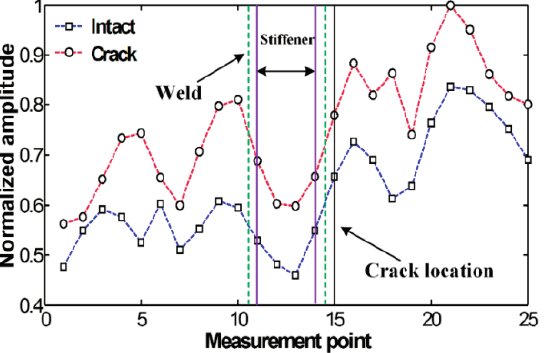
Figure 3. Spatial variations of cumulative Lamb wave energy obtained from the intact and cracked areas of the steel